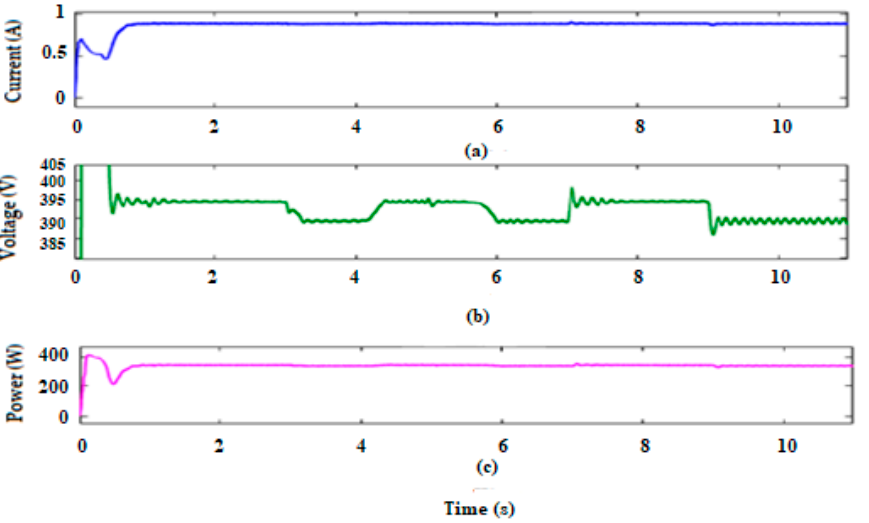
Figure 14. Waveforms of the output current ( a ), voltage ( b ), and power ( c ) of the DC-DC high gain converter.